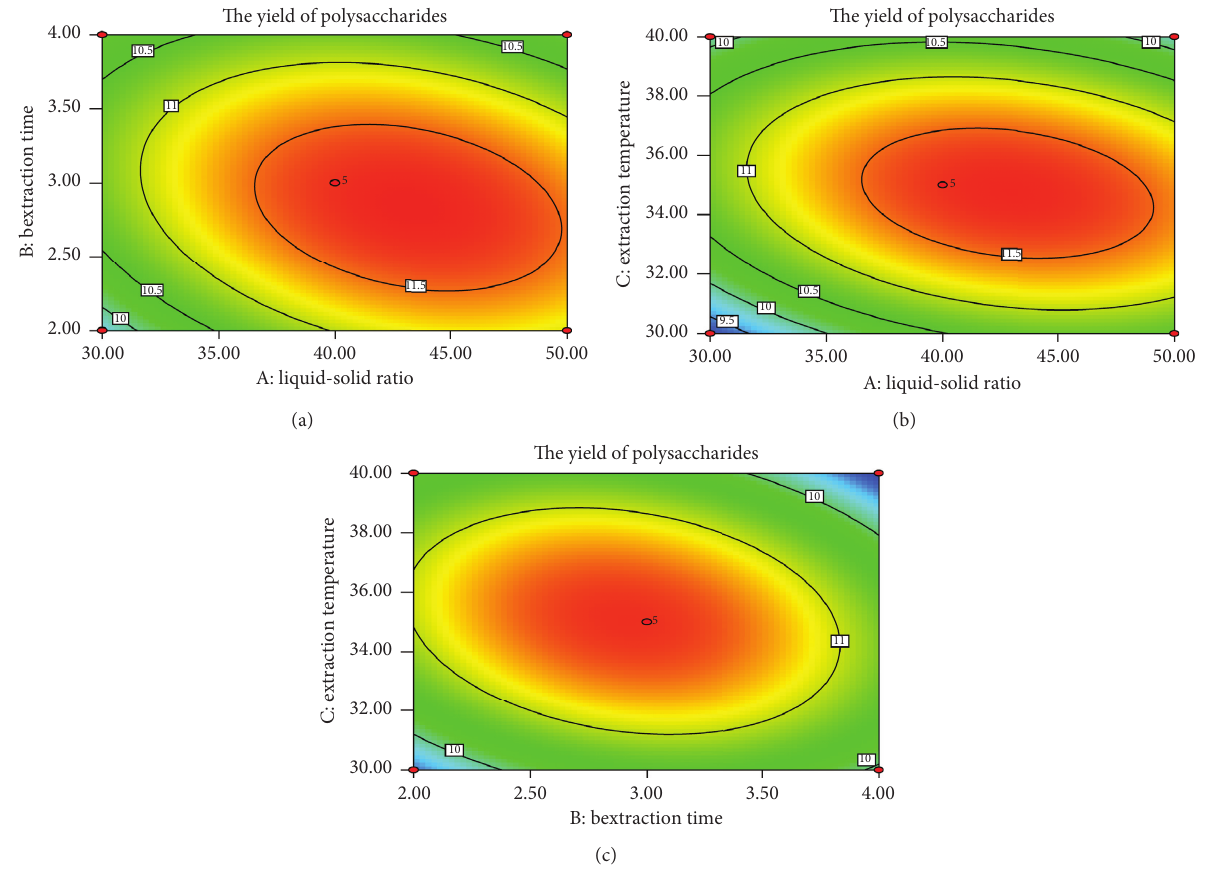
Figure 2: Contour plots. (a) PNMP yield (%) using homogenate extraction method as a function of liquid-solid ratio ( X time ( X 2 ); (b) PNMP yield (%) using homogenate extraction method as a function of liquid-solid ratio ( X 1 ) and extraction temperature ( X 3 ); (c) PNMP yield (%) using homogenate extraction method as a function of extraction time ( X 2 ) and extraction temperature ( X 3